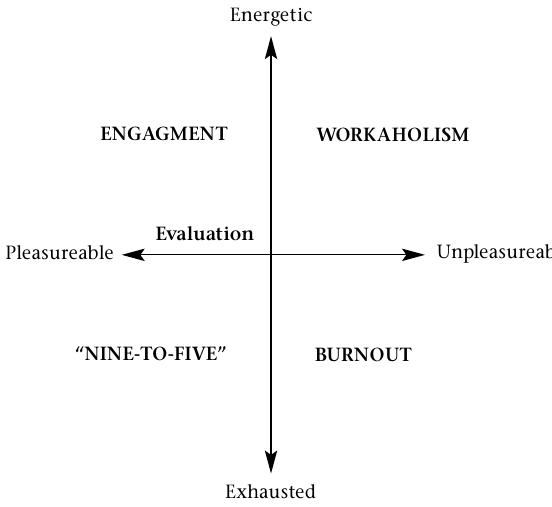
Figure 1: A taxonomy of well-being at work Schaufeli and Bakker (2001) distinguish between two dimensions that could be used to classify four types of well- being at work. The horizontal axis represents the extent of pleasure at work (i.e. pleasurable versus unpleasurable). The vertical dimension relates to the mobilisation of energy. This taxonomy makes it possible to distinguish between engagement and burnout, but also workaholism and a type of work experience called